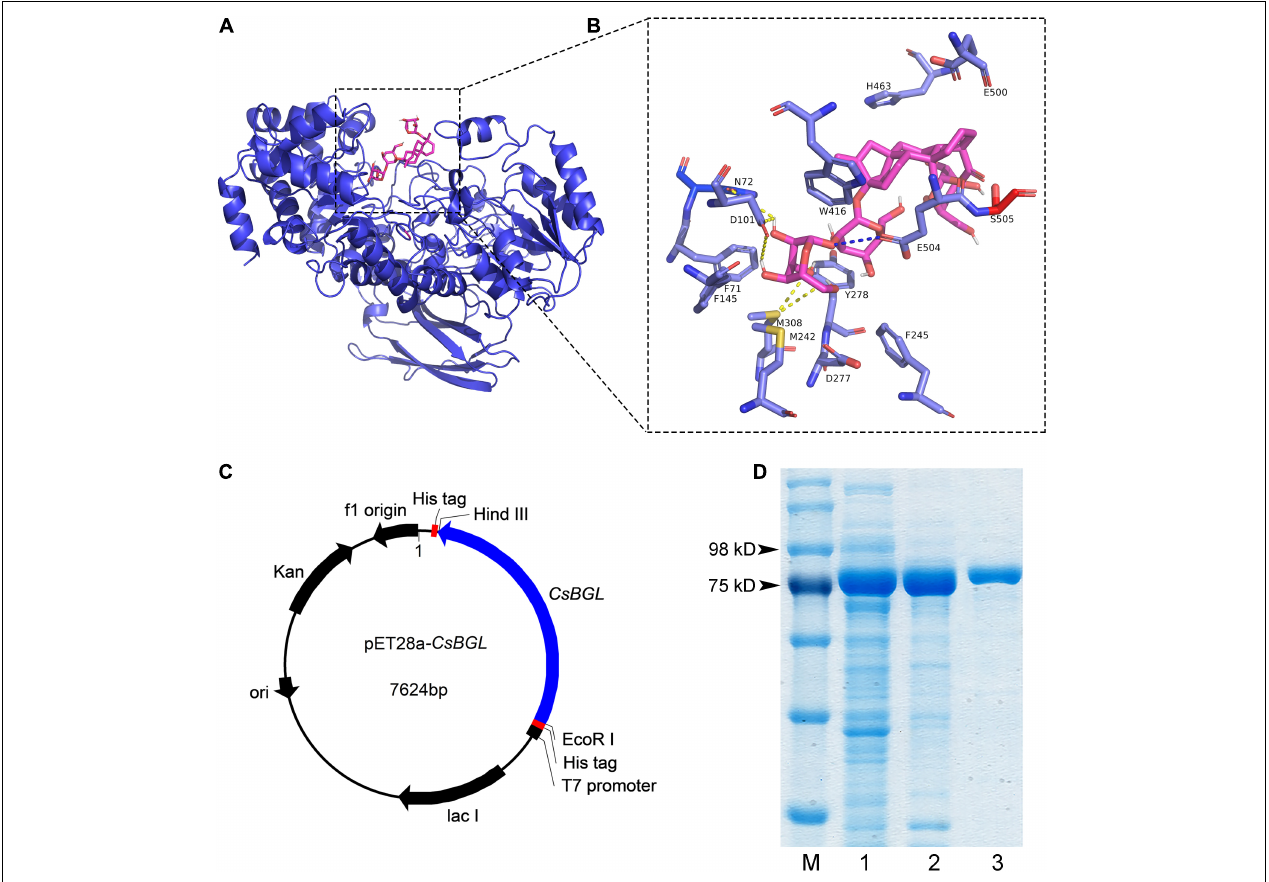
FIGURE 1 | Structure modeling analysis of Cs BGL and the heterologous expression of the Cs BGL. (A) The putative 3D structure of Cs BGL (blue) with stevioside (pink). The structure of Cs BGL was modeled using Bt BGL (PDB entry 5xxn) from Bacteroides thetaiotaomicron as the template. (B) Cs BGL-stevioside interactions. Hydrogen bonds are shown in yellow dotted lines. The unique interaction between E504 (the general acid/base) and glycosidic oxygen is shown in blue dotted line. (C) The map of constructed plasmid of p ET28a- Cs BGL. The cloned gene of Cs BGL has 2271 nucleotides without the signal peptide and termination codon. It was inserted between Hin dIII and Eco RI of p ET28a plasmid. (D) SDS-PAGE analysis of Cs BGL: lane M, protein marker; lane 1, the soluble-lysate after centrifugation; lane 2, the lysate precipitation; lane 3, purified recombinant Cs